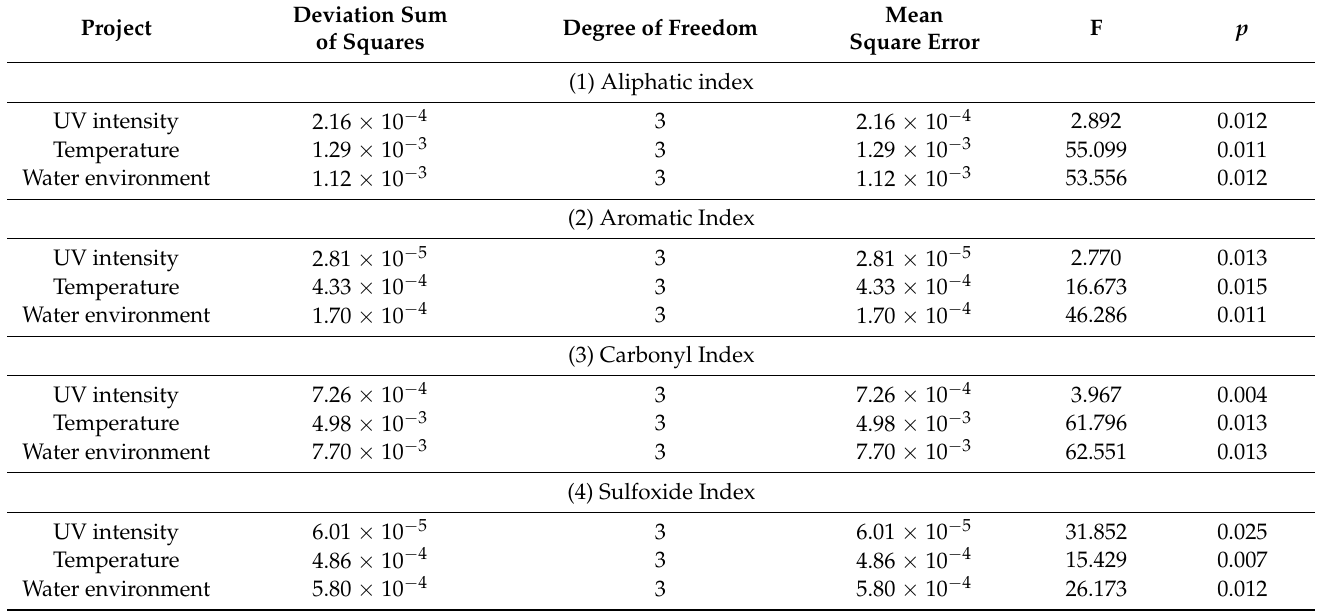
Table 5. Analysis of variance